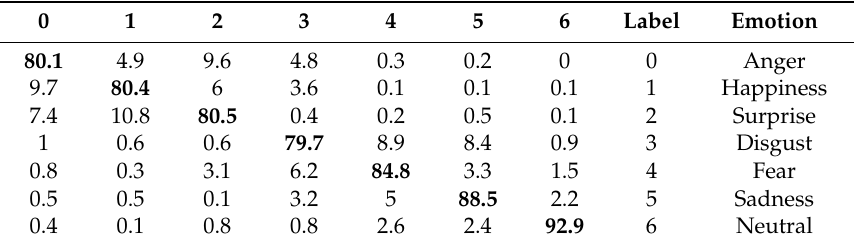
Table 10. Confusion matrix using geometric and kinematic features.